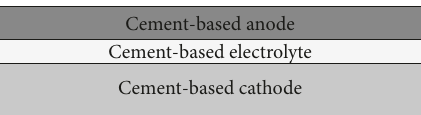
Figure 3: Proof of concept layered battery using cement as the continuous constituent throughout the layers